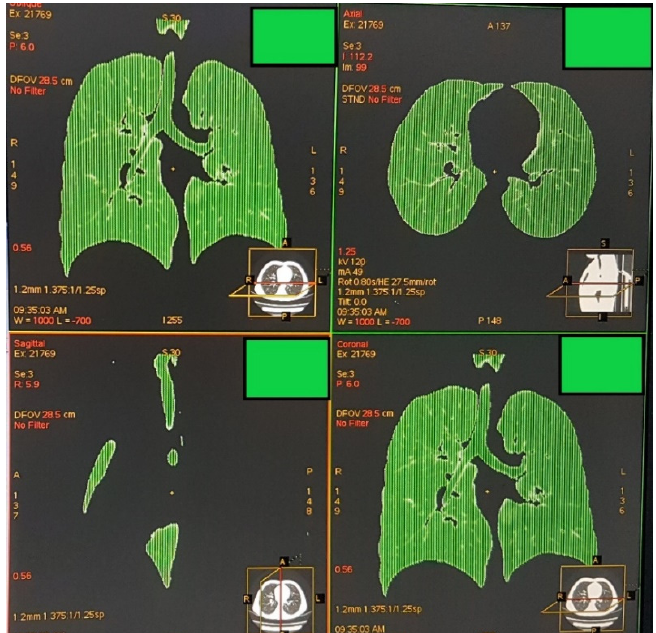
Figure 1. “Lung” was chosen as the imaging window so that other structures were not shown. Air located outside the chest (e.g., gastric air bubble) and outside the subject’s body was still visible and included in the automatically derived attenuation measurements. Thus, it was removed manually, and at the end of the process, only the lung parenchyma, the trachea and bronchi were